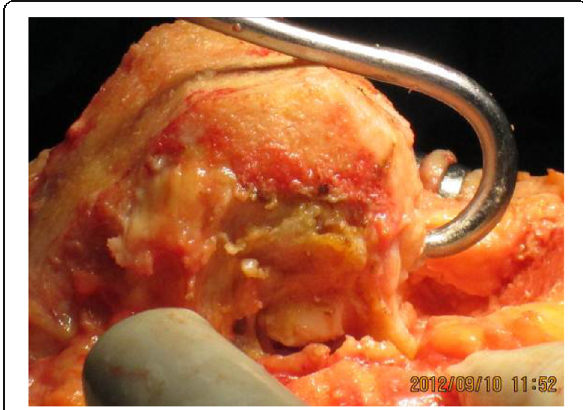
Fig. 4 The LCL was detached from the lateral femoral condyle if necessary